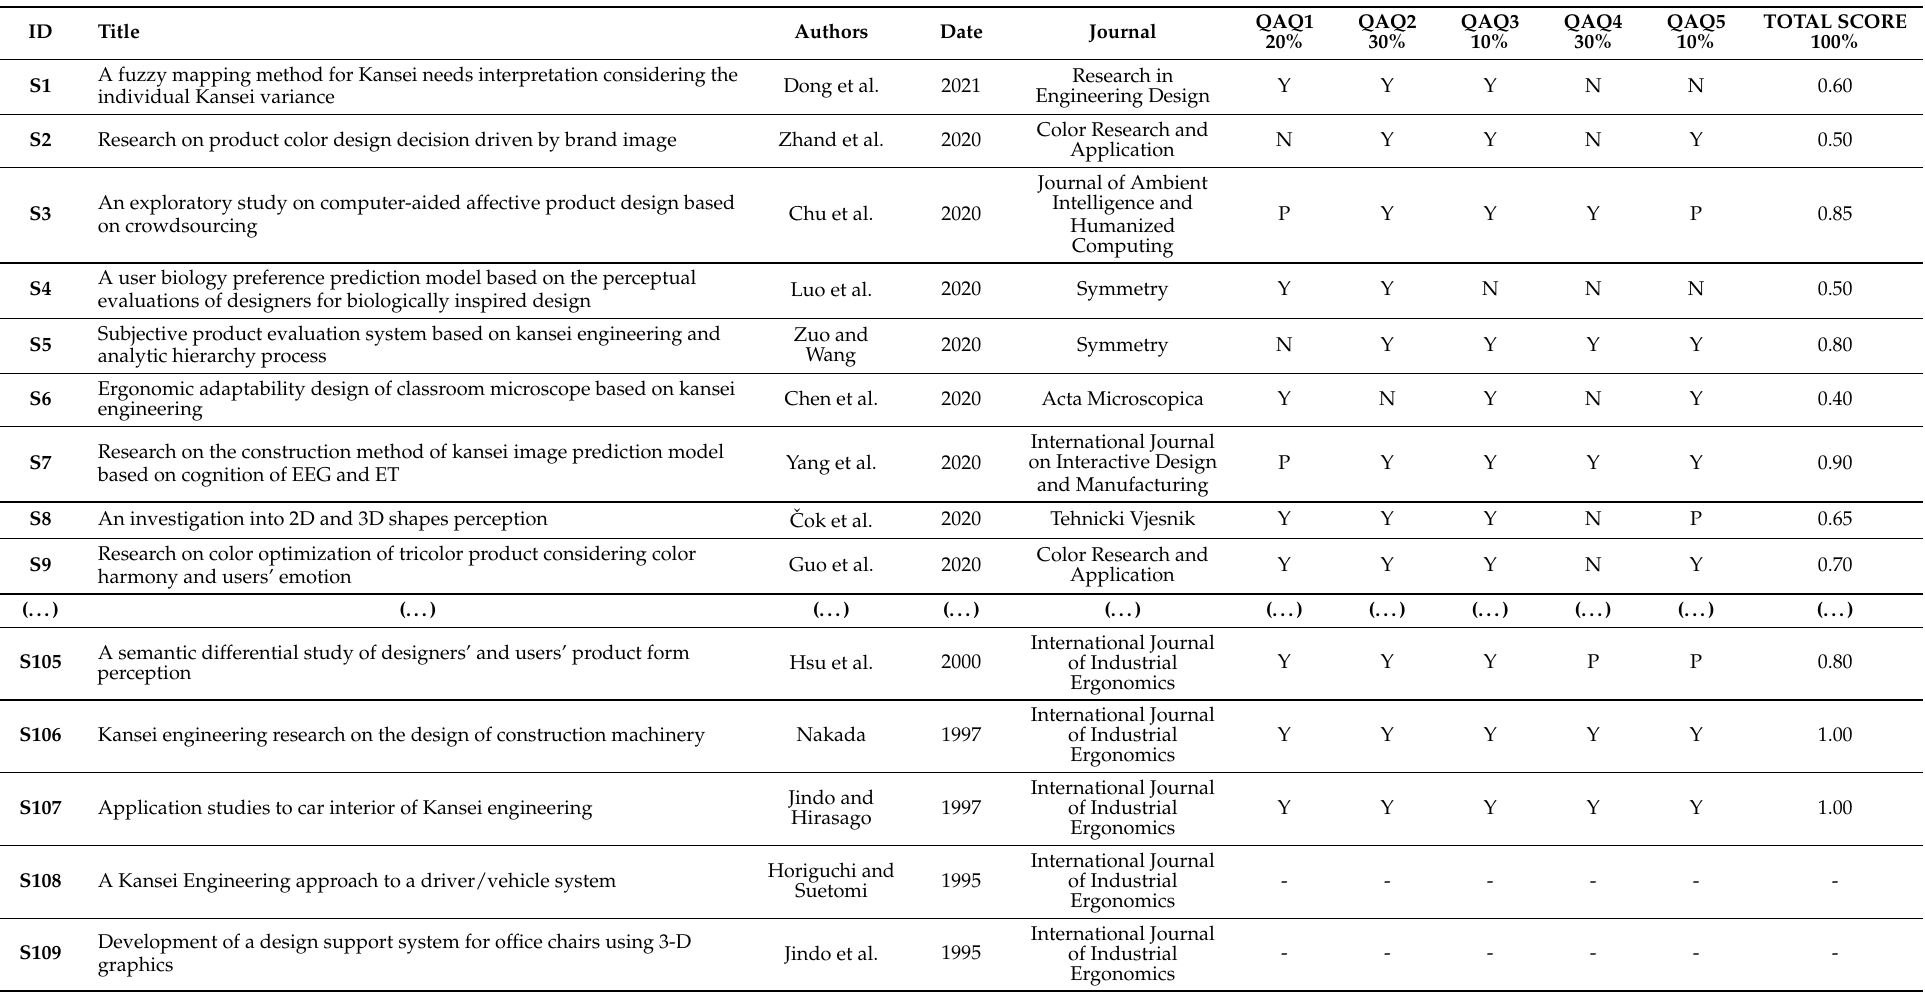
Table 3. Extracted data from selected